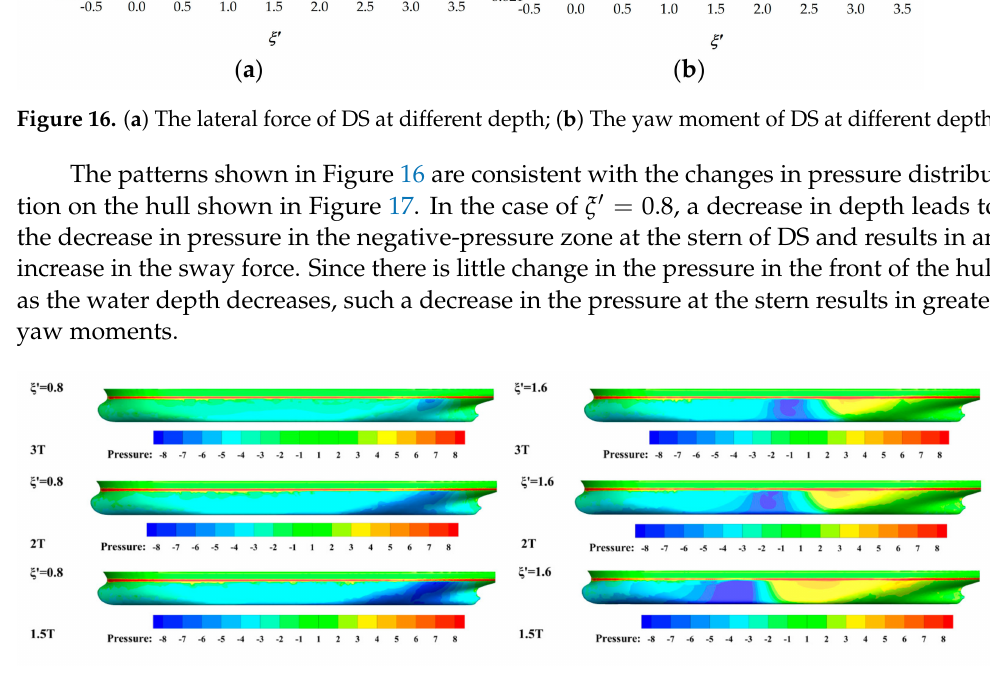
Figure 17. The dynamic pressure distribution of DS’s side surface at different depth. In the case of ξ (cid:48) = 1.6, with the decrease in depth, the negative-pressure zone moves forward and the positive-pressure zone expands in area, which intensifies the bow attraction and stern repulsion of